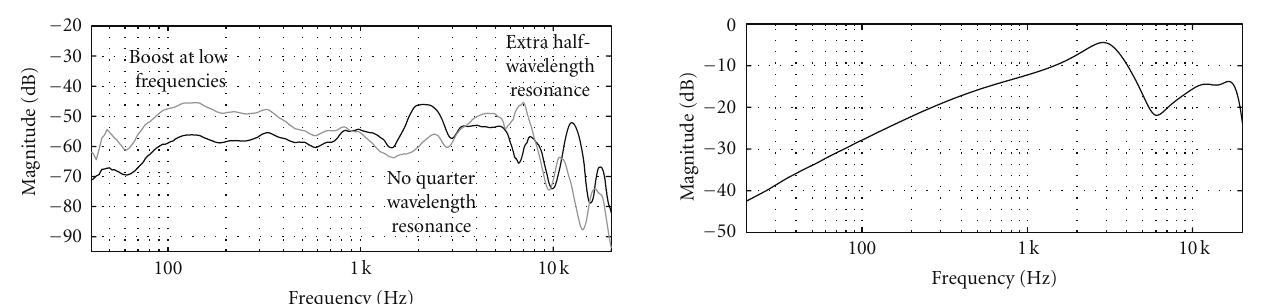
curve depicts the open ear case and the gray